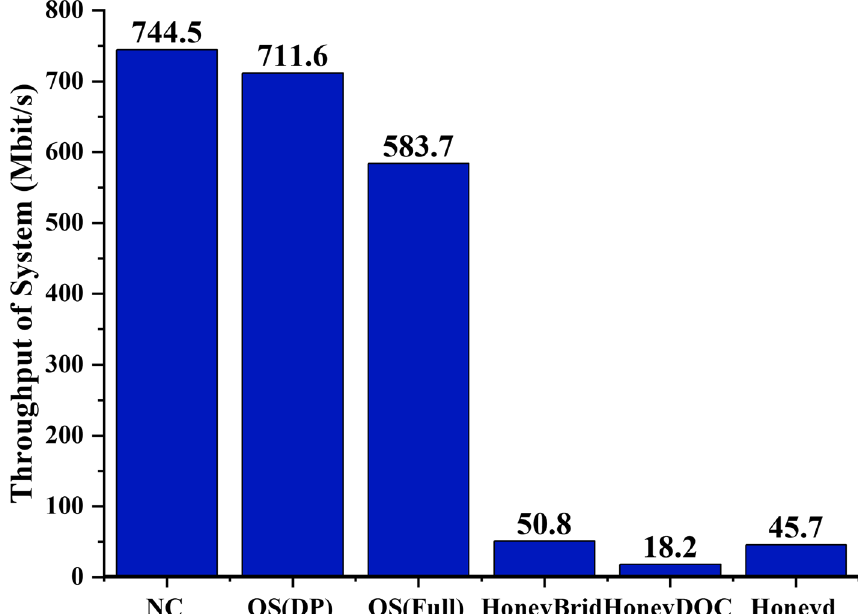
Fig. 12 System Throughput